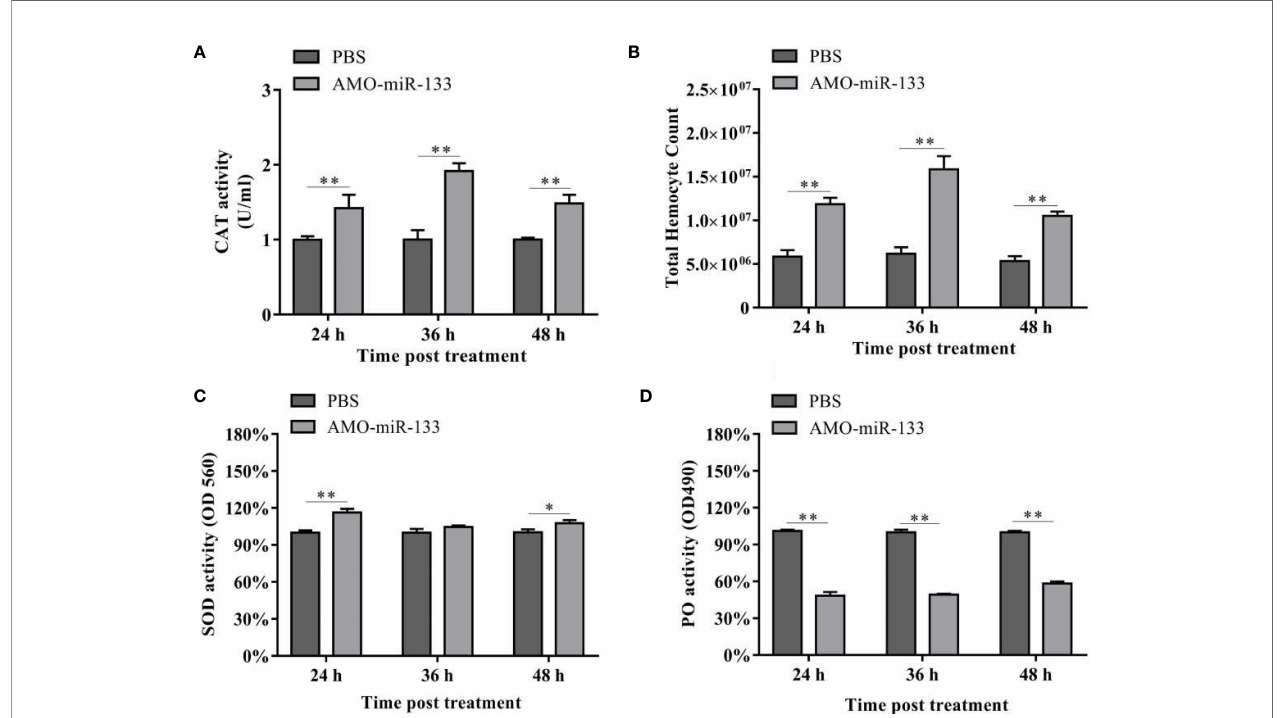
FIGURE 3 | (A) Effect of AMO-miR-133 on CAT activity of healthy S. paramamosain at 24, 36, and 48 h after AMO-miR-133 treatment. (B) Effect of AMO-miR-133 on the total hemocyte counts at 24, 36, and 48 h after AMO-miR-133 treatment. (C) Effect of AMO-miR-133 on SOD activity at 24, 36, and 48 h after AMO-miR- 133 treatment. (D) Effect of AMO-miR-133 on PO activity at 24, 36, and 48 h after AMO-miR-133 treatment. The results are shown as mean ± standard deviation of three independent experiments. Signi fi cant difference between different samples based on t-test analysis is indicated by * P < 0.05 and ** P <